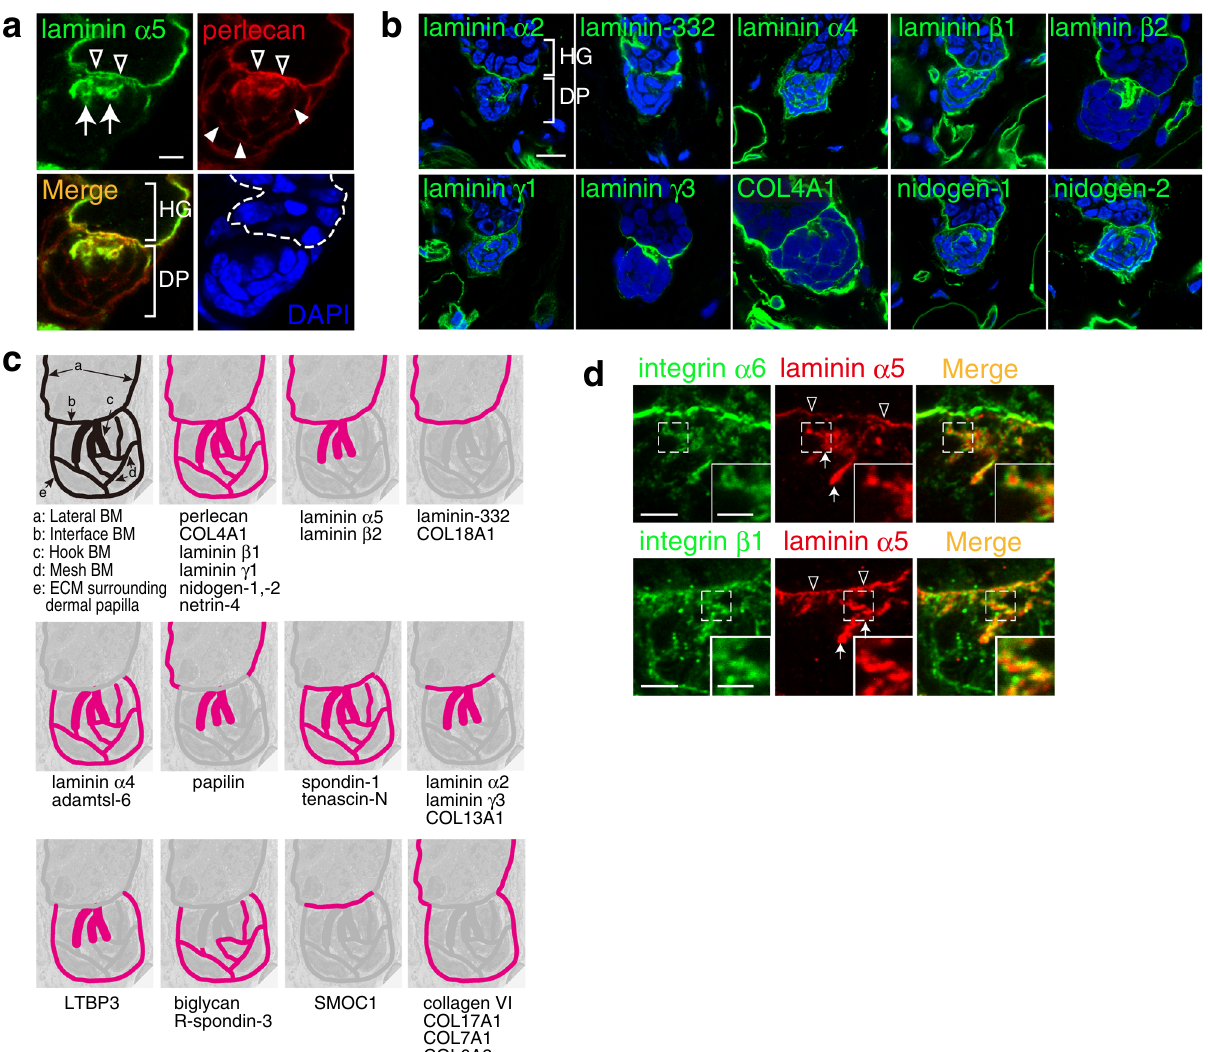
Fig. 7 Identi fi cation of hook and mesh basement membranes. a Immuno fl uorescence labelling of dorsal telogen HFs. Both laminin α 5 (green) and perlecan (red) are detected in a hook-shaped basement membrane (BM; arrows) extending from the interface BM (open arrowheads). Perlecan also forms a mesh-like BM ( fi lled arrowheads) within the dermal papilla (DP). Dashed line indicates the epidermal – dermal boundary. b Immunolocalizations of major BM proteins (green) in the hook and mesh BMs of dorsal telogen HFs. Nuclei were stained with DAPI (blue). c Graphical representation of the regional BM compositions in the hair germ (HG) – DP unit. Upper left-hand panel depicts the distinct BM structures. Other panels schematically summarize deposition patterns of BM components examined in ( a , b ) and Supplementary Fig. 5. d Close localization of dermal integrins with laminin α 5-containing hook and interface BMs. Integrin α 6 (upper panels, green) or β 1 (lower panels, green) was co-immunostained with laminin α 5 (red). Insets are magni fi ed views of the dotted squares. Arrows and open arrowheads indicate the hook BM and interface BM, respectively. Scale bars: 5 μ m ( a , b ), 3 μ m ( d ), 1.5 μ m (insets in ( d